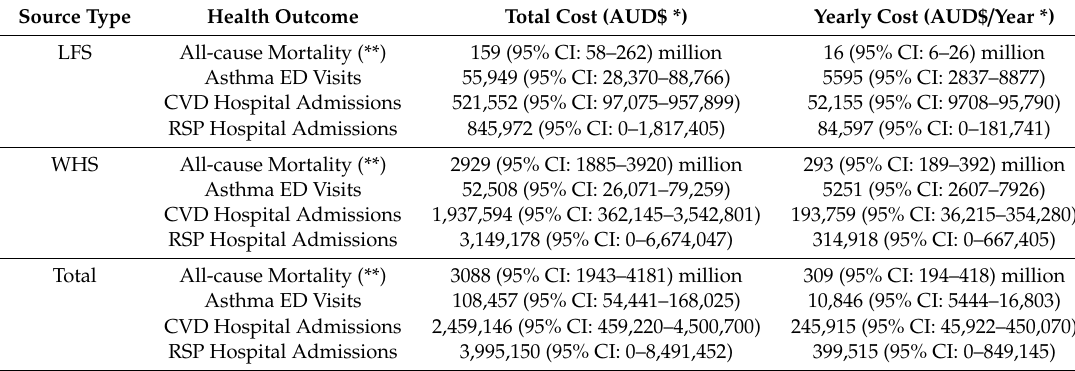
Table 5. Estimated total costs and costs per year by source type and health outcome.